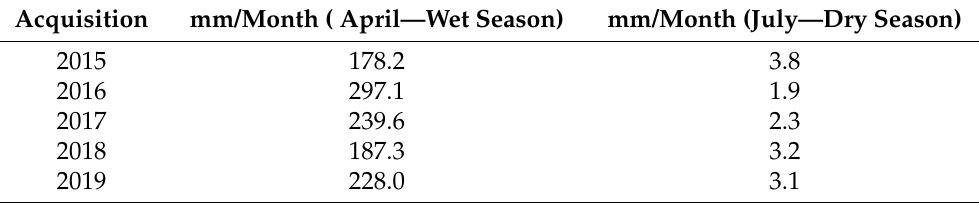
Table 1. Monthly precipitation (mm/month) in April and July for acquisitions from 2015 to 2019 (data for 2020 and 2021 not available) provided by CRU TS multivariate climate dataset